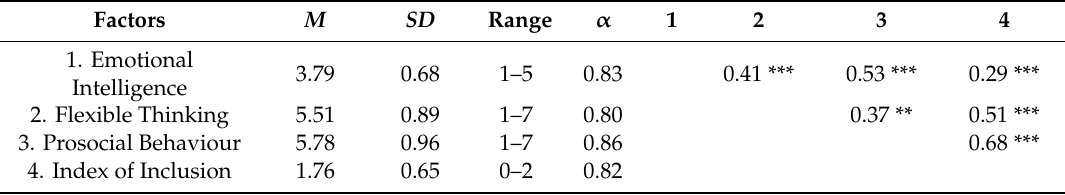
Table 1. Descriptive statistics and correlations between all